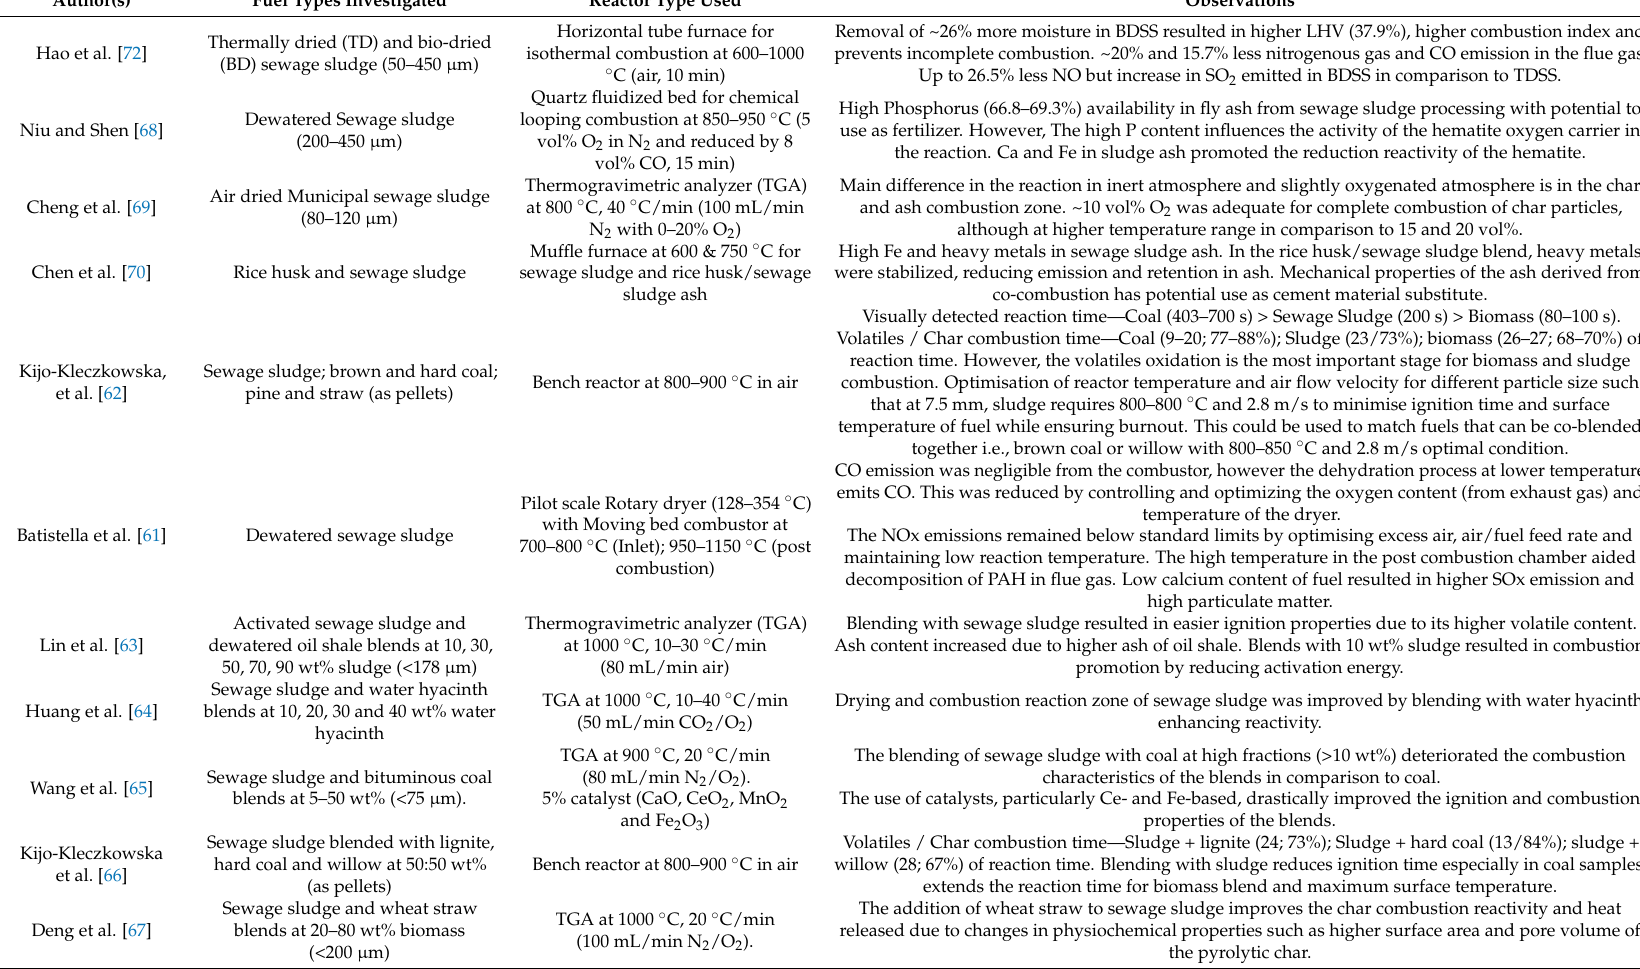
Table 3. Summary of key research on combustion of sewage